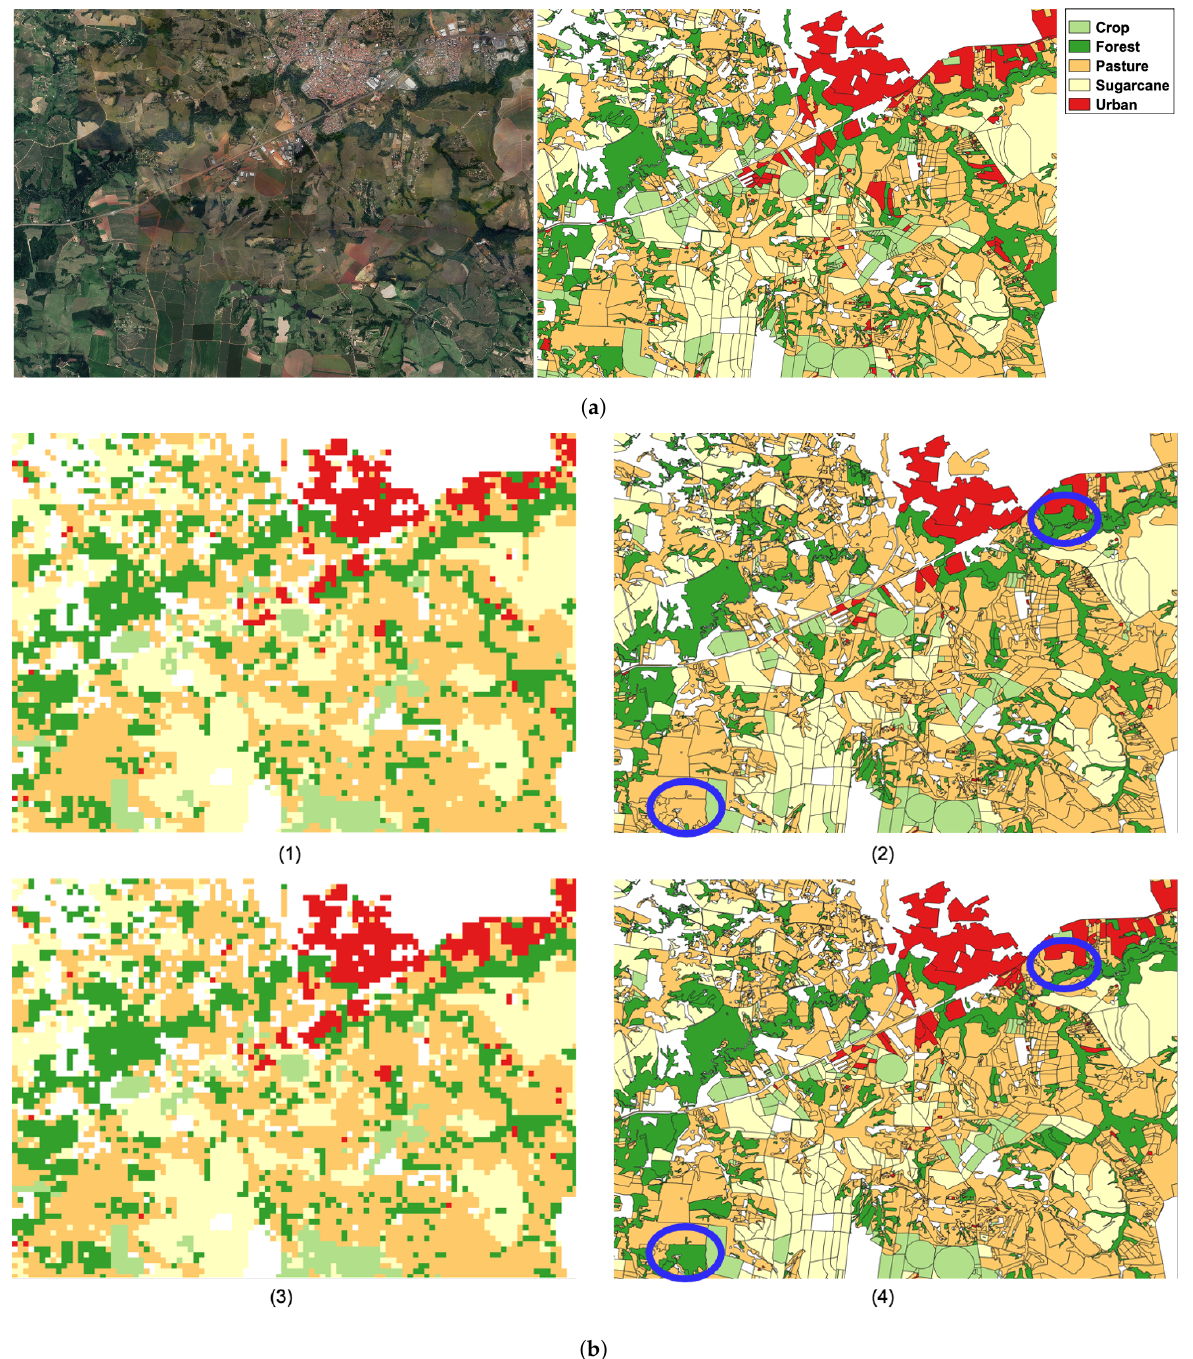
Figure 9. Comparison of the SVM classifier maps over a 10 × 7 km close-up of the study area: ( a ) reference data and ( b ) results from: ( 1 ) amplitude and field pixel sampling; ( 2 ) amplitude and field sampling; ( 3 ) amplitude + coherence and field pixel sampling; ( 4 ) amplitude + coherence and field